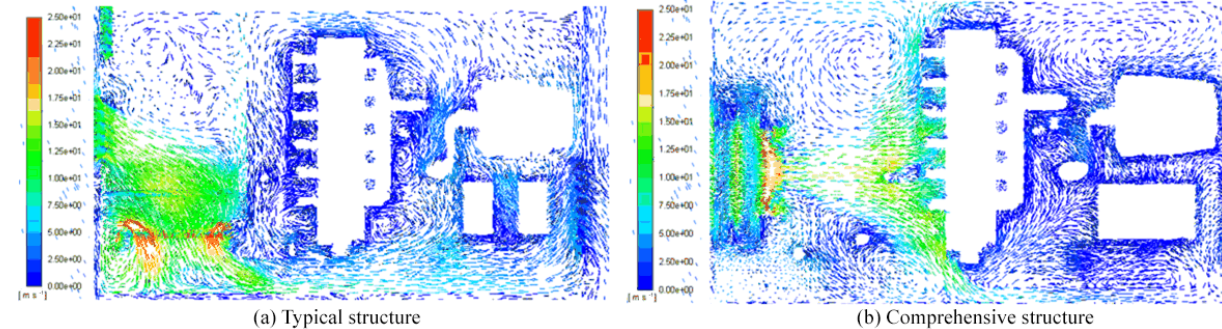
Figure 9. Comparison of velocity fields within the plane Z = 475mm (unit: ms − 1 ).